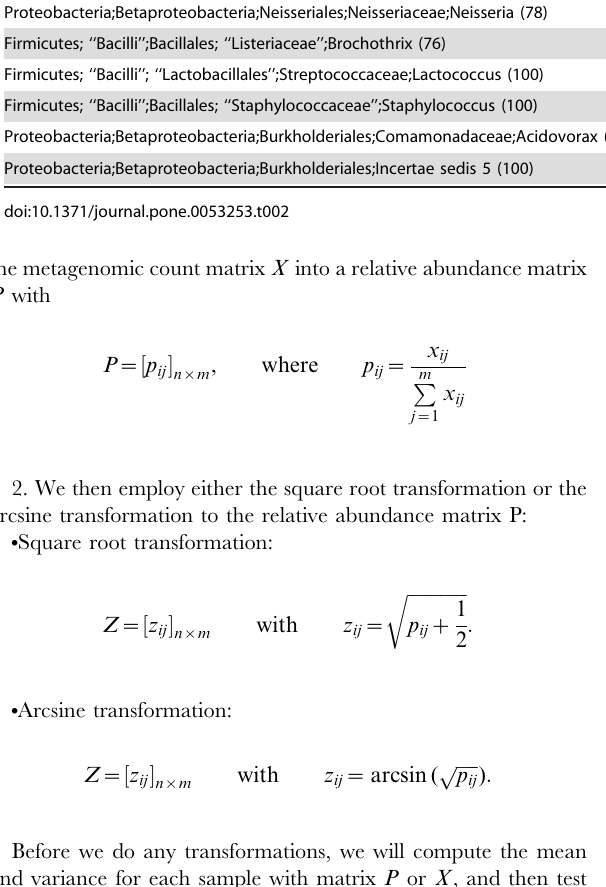
Firmicutes;‘‘Bacilli’’; ‘‘Lactobacillales’’;Lactobacillaceae;Lactobacillus (100) Firmicutes; ‘‘Bacilli’’; ‘‘Lactobacillales’’;Streptococcaceae;Streptococcus (100)